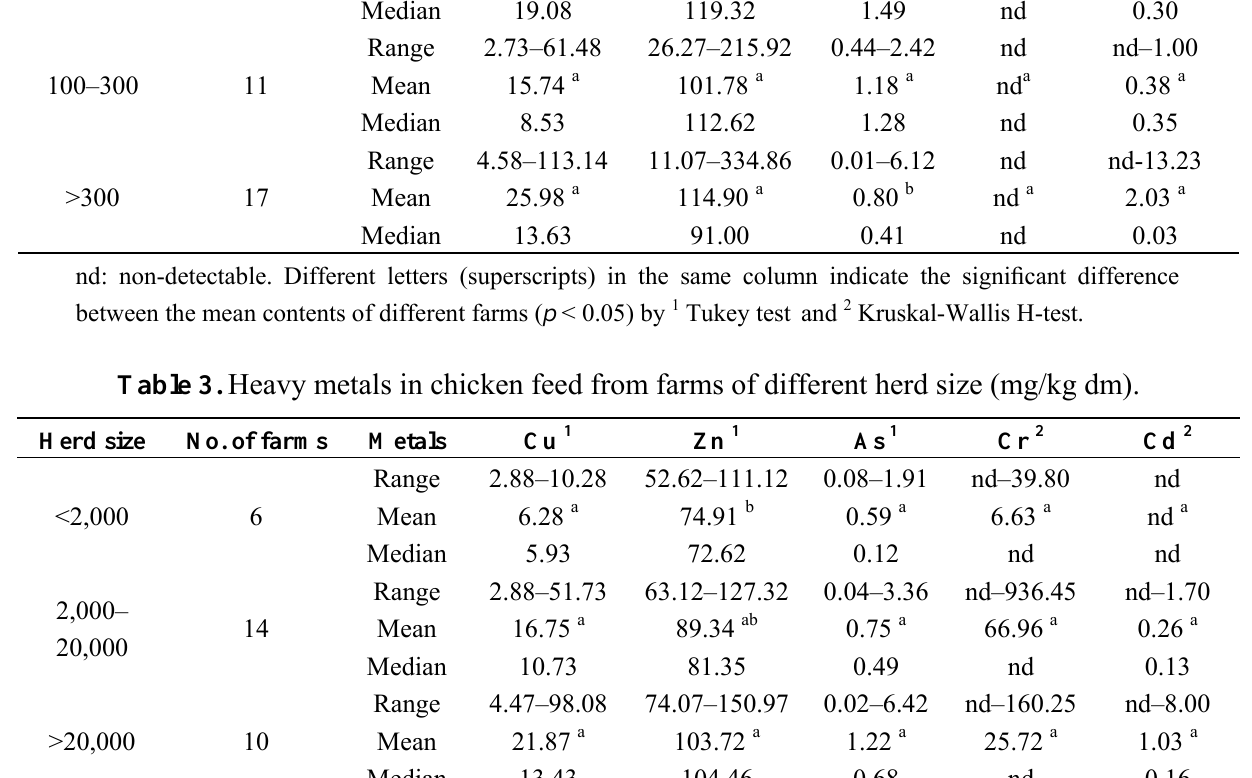
Table 4. Heavy metals in pig feeds from farms of different herd size (mg/kg dm). Herd size